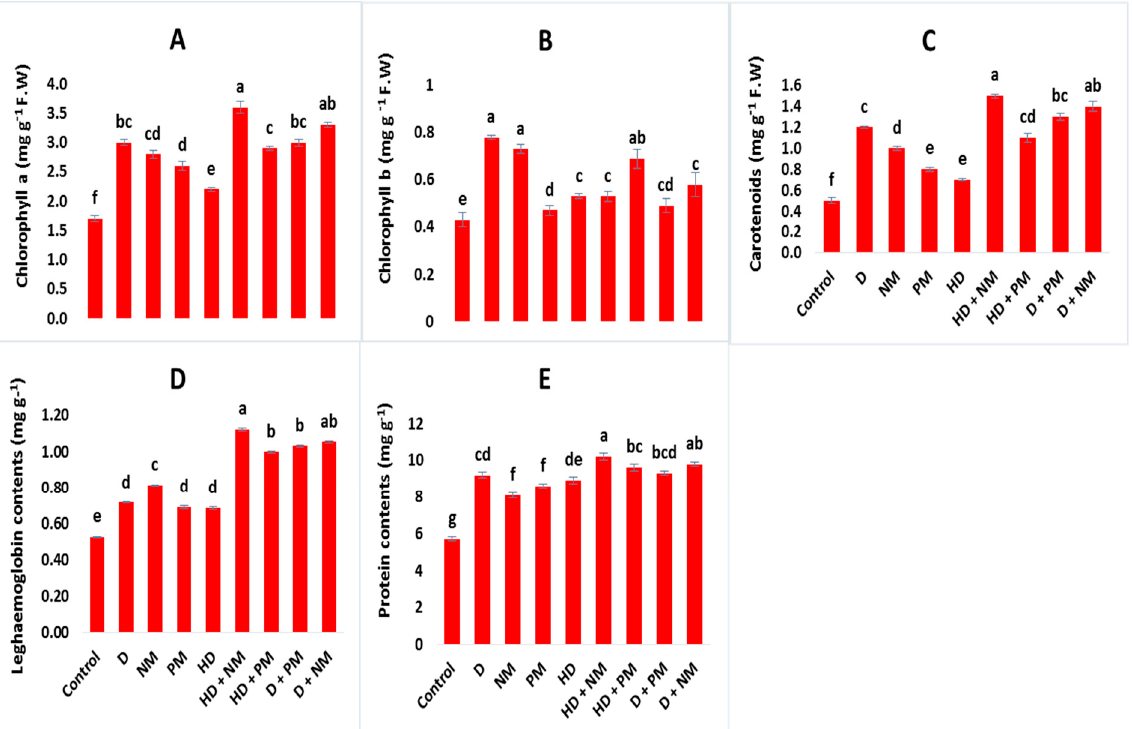
Figure 3. Effect of animal manures with DAP fertilizer on physiological attributes of chickpea ( A ) chlorophyll a, ( B ) chlorophyll b, ( C ) carotenoid contents, ( D ) leghaemoglobin contents and ( E ) protein contents of chickpea. While D: Recommended DAP; NM: Normal manure; PM: Processed manure; HD: Half of the recommended dose of DAP. Figure bars are showing the mean values ( n = 3). All means followed by different letters have statistically significant differences according to Tukey’s HSD test at probability level of 0.05.